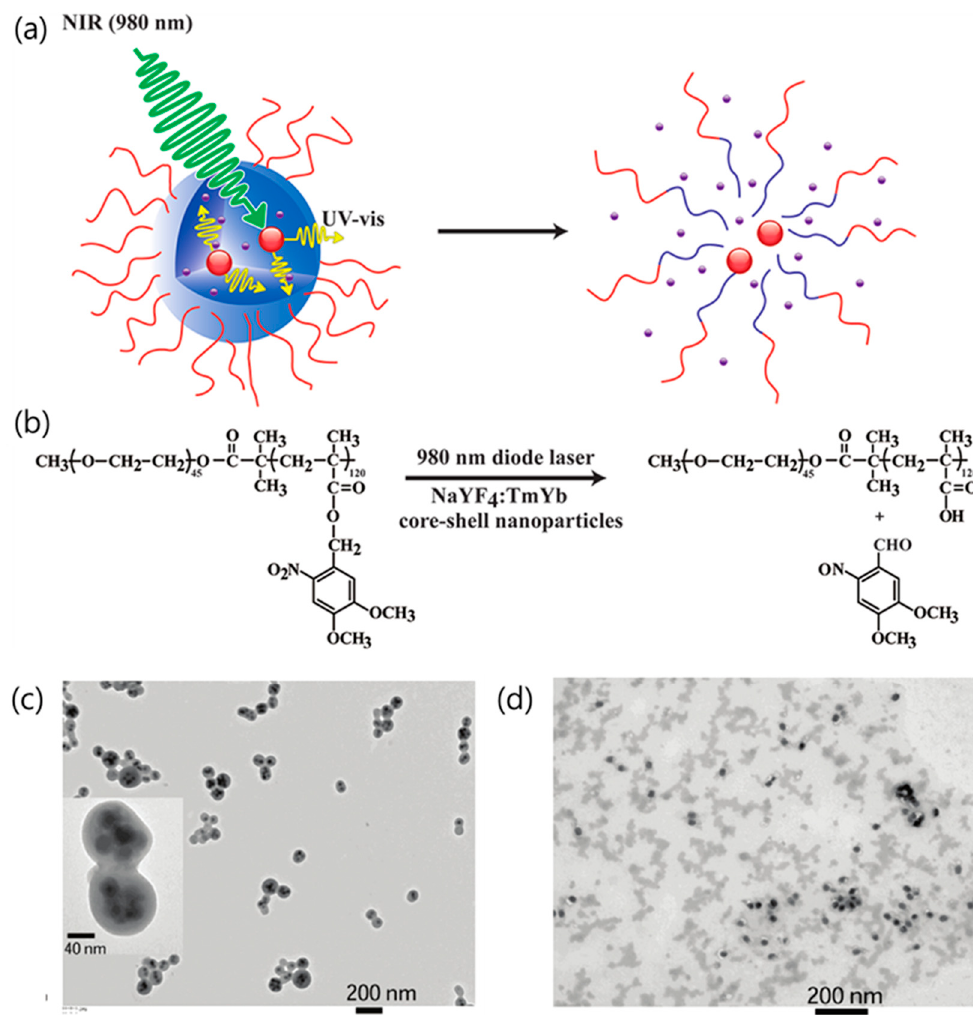
Figure 5. ( a ) Schematic of drug release resulting from NIR light-triggered dissociation of UCNP-loaded block copolymer (BCP) micelles. ( b ) Photoreaction scheme showing cleavage of the BCP backbone by NIR irradiation. ( c , d ) TEM images of the UCNP-loaded BCP micelles ( c ) before and ( d ) after NIR light irradiation. Reproduced with permission from [63]. Copyright American Chemical Society, 2011.